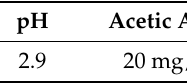
Table 2. Chemical composition of the salt water–acetic acid